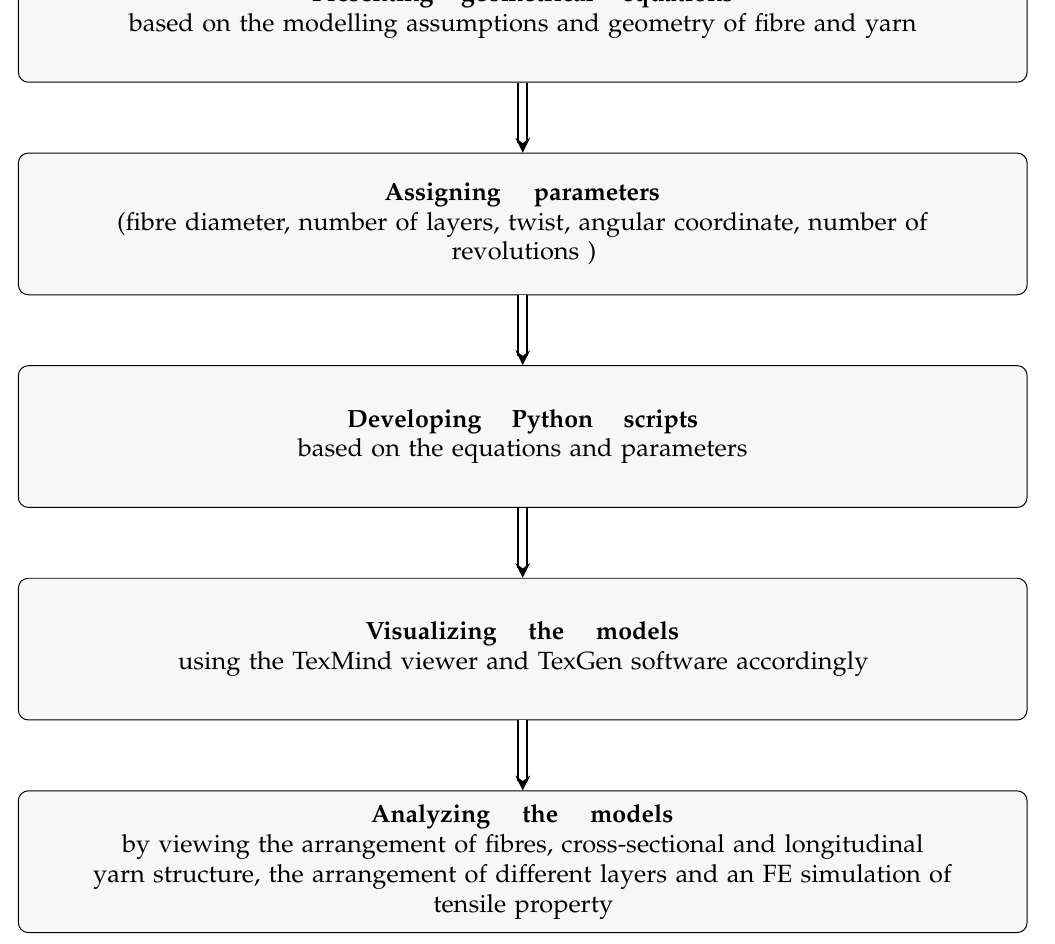
Figure 1. Procedure for 3D geometrical yarn